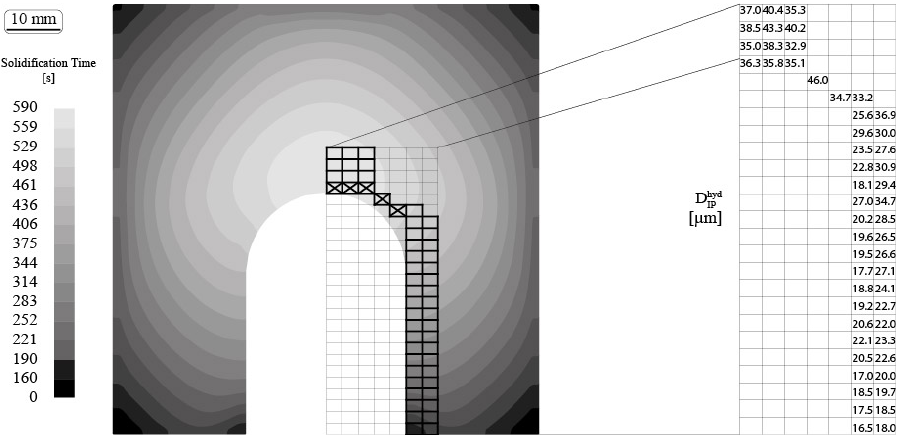
Figure 9. Simulated local solidification time and the measured hydraulic diameter of the intradendritic phase in the right ‐ hand side grid. The gray color scale plotted on the cross section of the MEP sample geometry represents the simulated local solidification time.